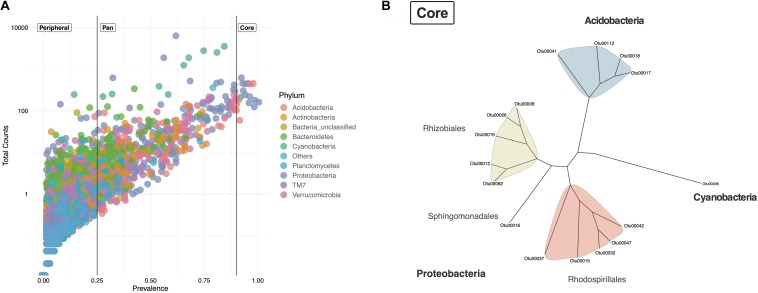
Lichen core microbiome of samples from two Paramos. (A) Prevalence of the total 20 174 OTUs across the 47 lichen samples and their total number of observations (counts). Taxa were defined as Core (prevalence ≥0.9), Pan (prevalence ≥0.25 and <0.9) and Peripheral (prevalence <0.25). OTUs are colored by phylum. (B) Neighbor-Joining tree of the lichen core microbiome.